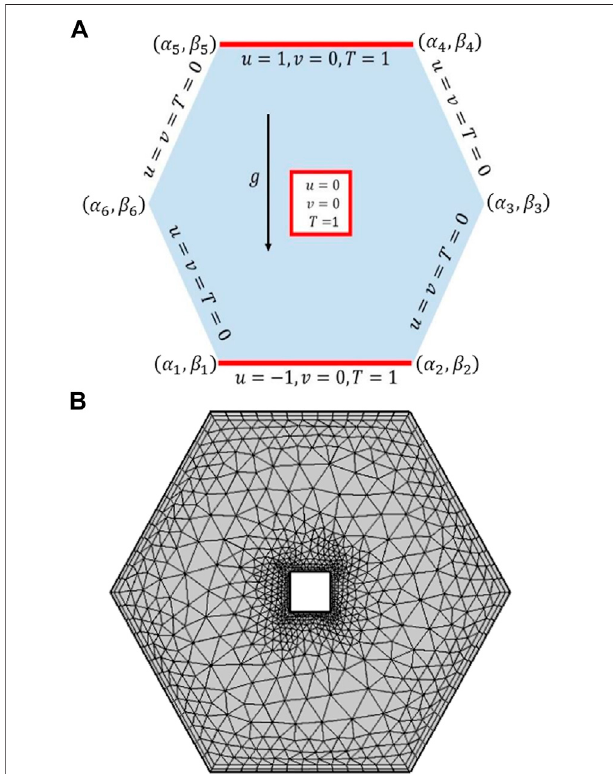
FIGURE 1 | (A) . Schematic diagram of the problem. Panel (B) computational grid at the coarse